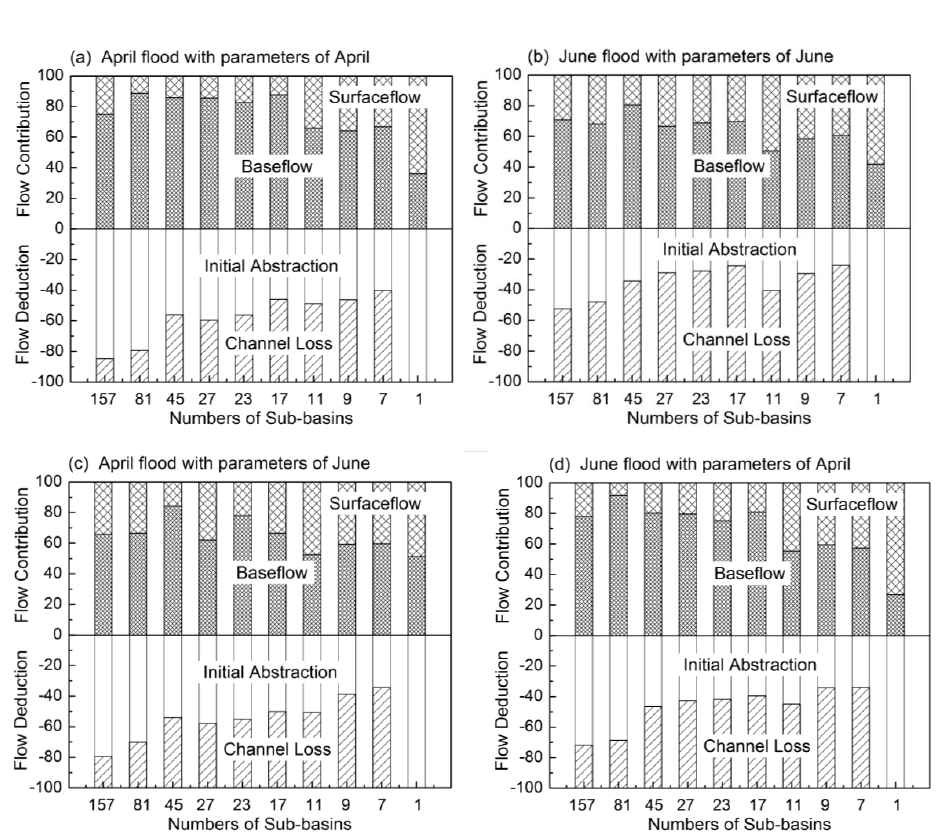
Fig. 10. Water balance – physical Fig. 10 Water balance-physical interpretation. 4